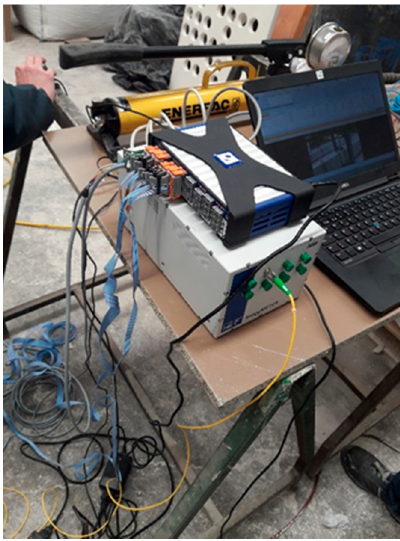
Figure 8. Data acquisition system installed. QuantumX, Interrogator and computer with Catman Easy software.